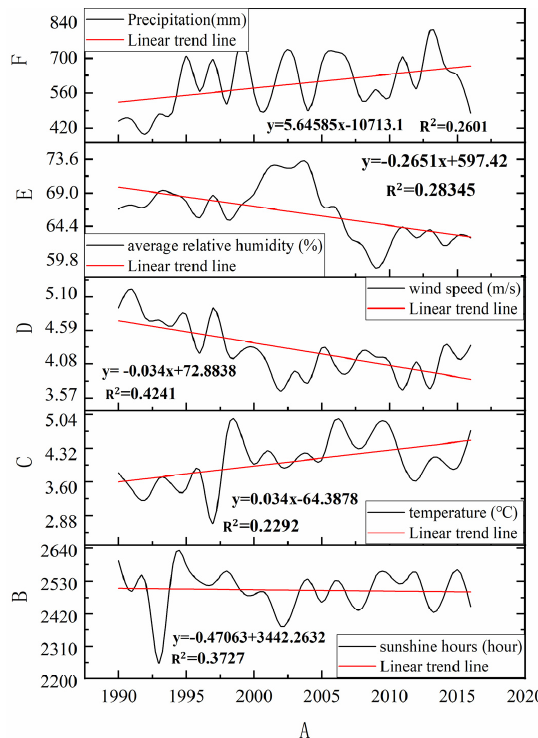
Figure 9. The thirty-year trend of climate factors. (A), year, (B), sunshine hours, (C), temperature, (D), wind speed, (E), average relative humidity, (F), precipitation. A tolerance of less than 0.1 indicates severe multicollinearity in the covariance statis- tics, and a variance expansion factor VIF, which was more significant than 10, indicates severe collinearity. When the VIF value is less than 10, we believe that the data conform to the multiple linear analysis, and there is no multicollinearity among the independent variables. It can be seen from the table that the VIFs of sunshine hours, average tempera- ture, average wind speed, average relative humidity, and precipitation are all less than 10, and their tolerances are all close to 0.8. It can be stated that there is no multicollinearity problem in this model. Analysis of variance (ANOVA) is a significant test invented by R.A. Fisher for the difference in the mean of more than one sample. This paper uses ANOVA to judge whether the regression equation is essential. The corresponding p -value in the ANOVA model, which is the sig in the table, is significant and indicates the size of the difference between the control and the experimental group. In the table, p = 0.011 < 0.05 suggests that the null hypothesis is supported. That is, the linear regression equation is significant. The corresponding T-test in Table 7 is to judge the importance of each vari- able of the regression equation. Table 7. Table of coefficients. Coefficients a Model